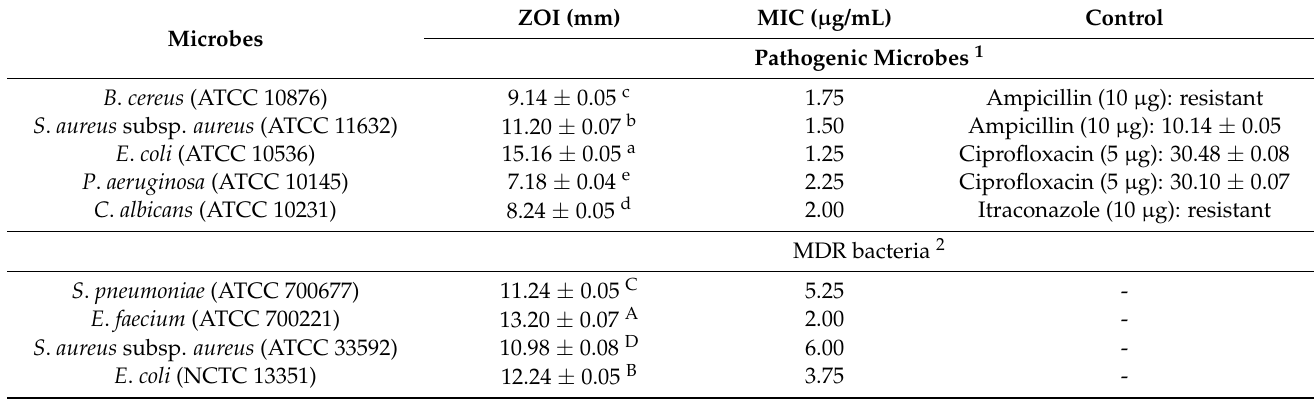
Table 2. Antimicrobial activity of the synthesized AgNPs against pathogenic and MDR microbes. Microbes